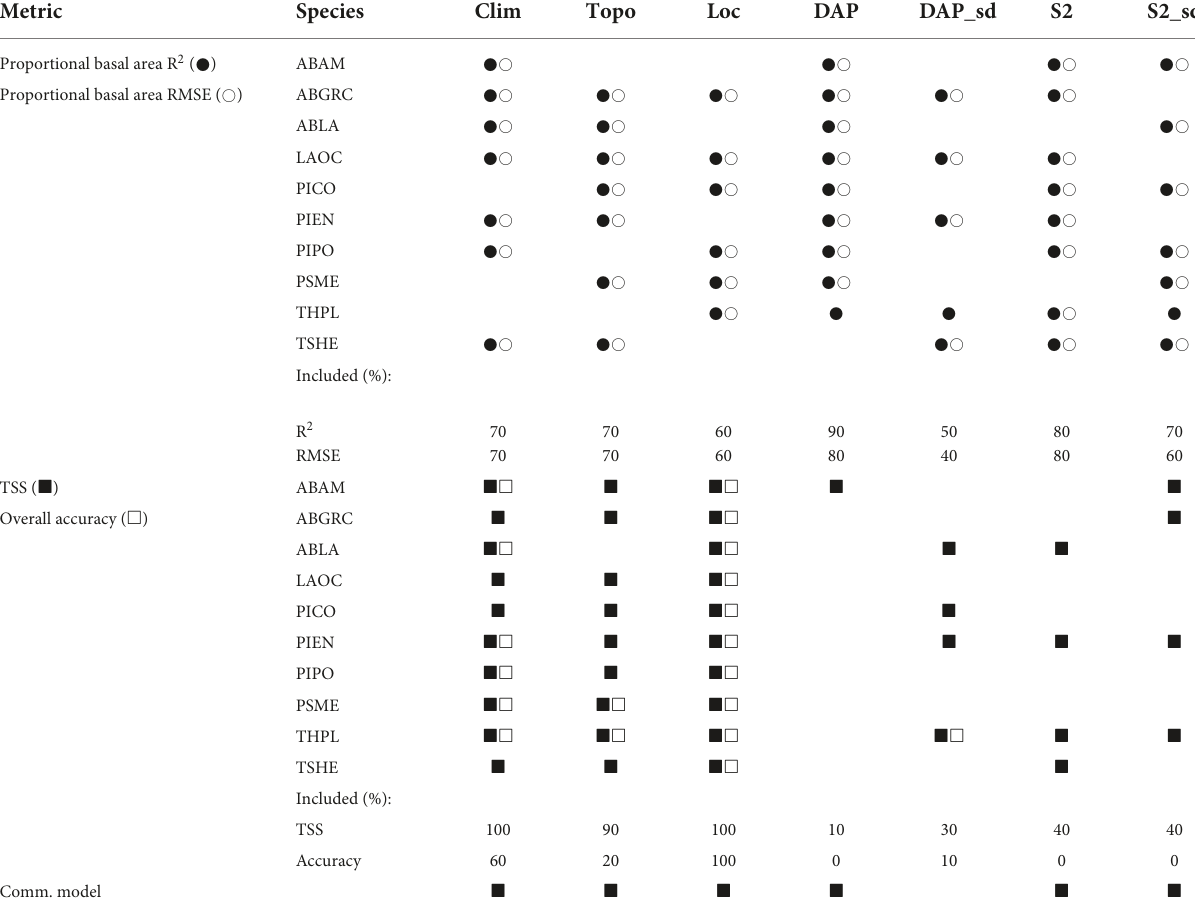
TABLE 2 Covariate group combinations for the best model for each species based on maximizing the performance metrics: R 2 and RMSE for proportional basal area and TSS and overall accuracy for species occurrence. Metric Proportional basal area R 2